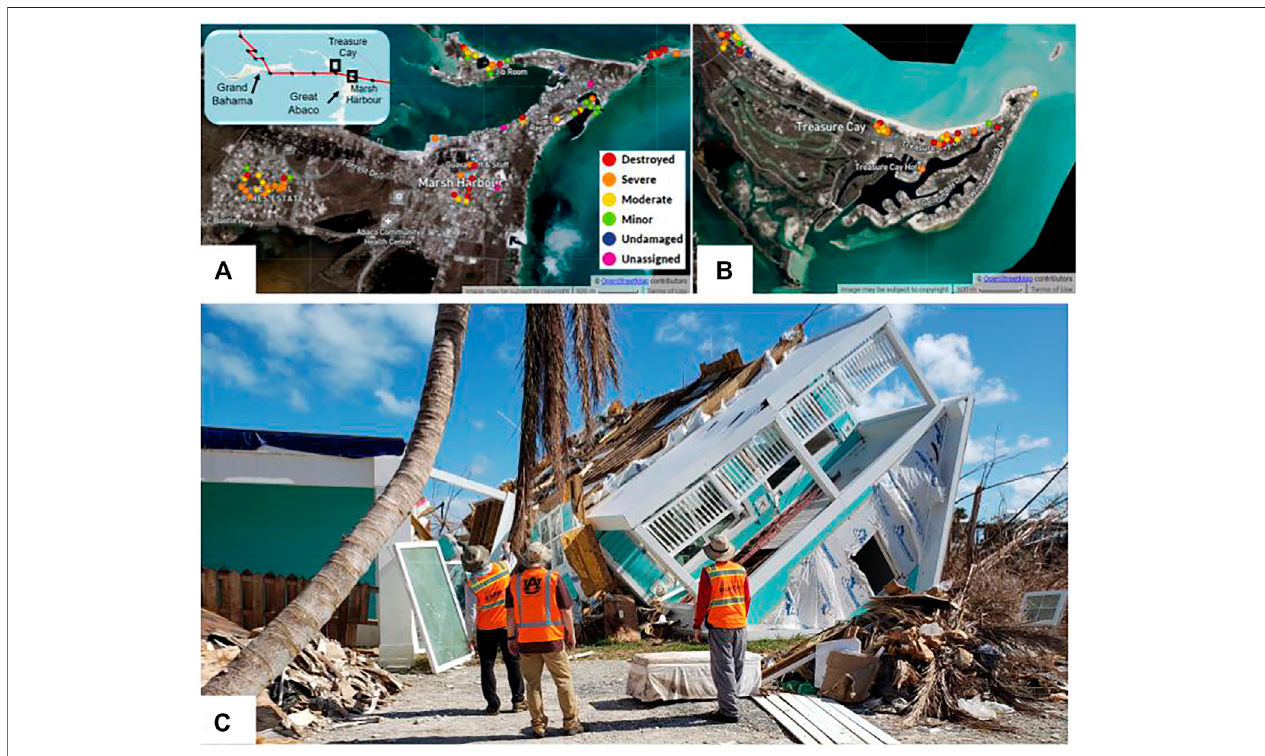
FIGURE9| Summaryofapp-based structuralassessments(coloredcircles) conducted byFAST-1afterHurricaneDorianintheBahamas:( A )Marsh Harbourwith inset map showing locations relative to hurricane track, ( B ) Treasure Cay, and example of recurring failure theme: ( C ) use of hurricane straps at the roof/wall connection, but poor bottom plate